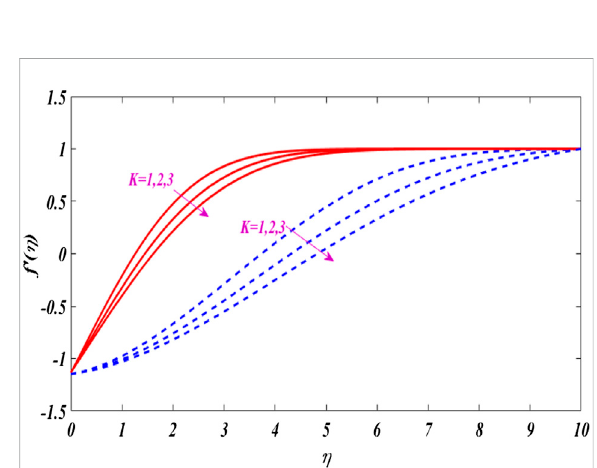
Dual solutions impact on for several